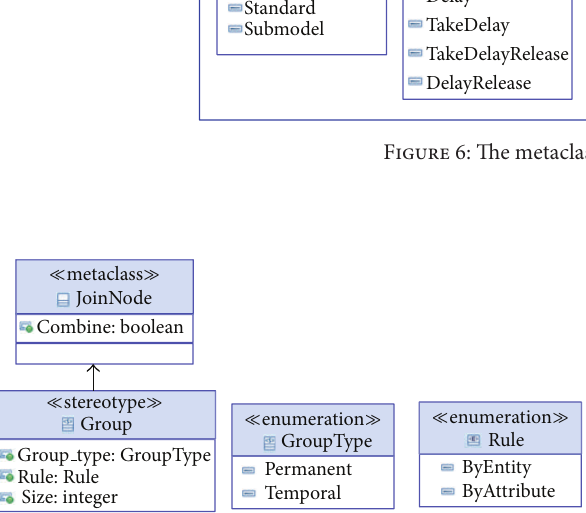
Figure 7: Metaclass JoinNode and its corresponding stereotype.